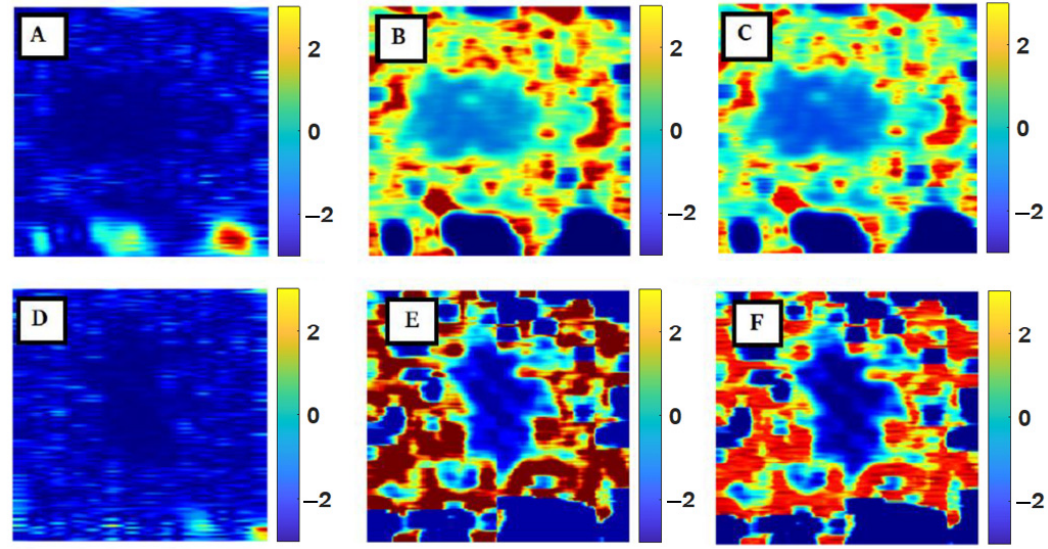
Figure 7. Example of Contourlet Coefficient at sub-band P4D32 ( A , D ); corresponding CP image ( B , E ); corresponding WCP image ( C , F ). The first row represents a benign case, and the second row represents a malignant case.